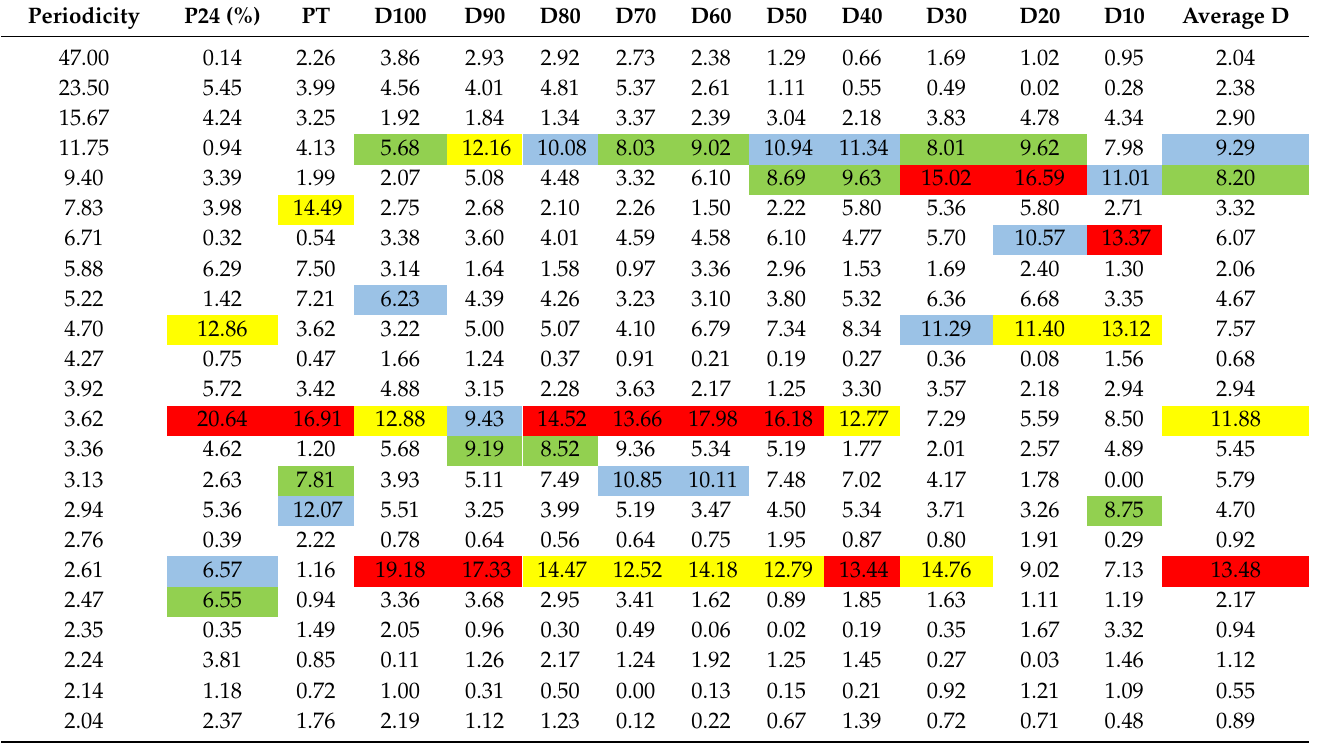
Table 5. Summary of the frequencies of greater significance in each series (% of periodogram), for the maximum intensities, total precipitation, and maximum precipitation in twenty-four hours (D10 to D100, PT and